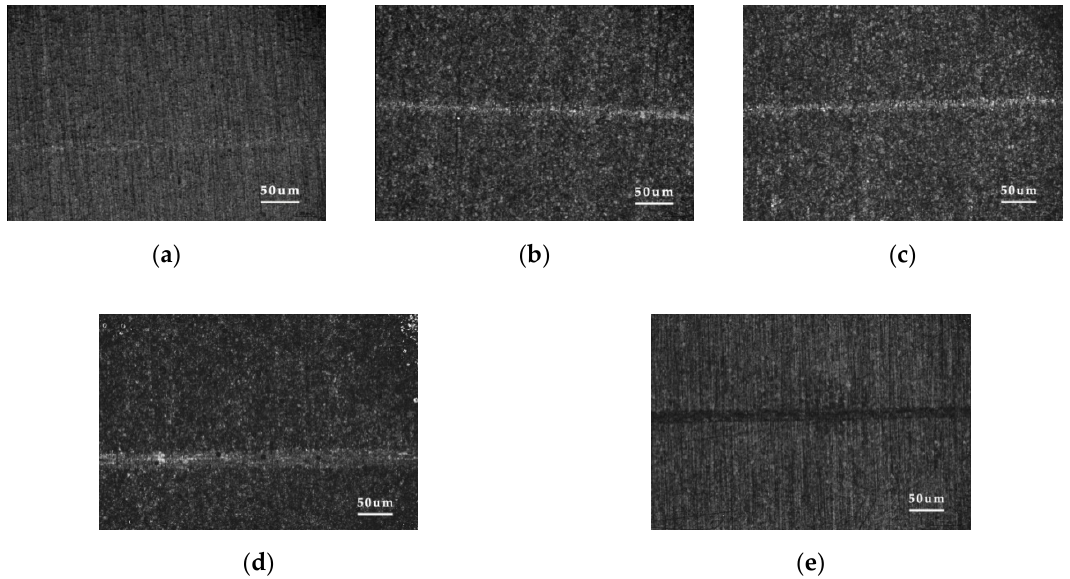
Figure 9. The photographs of scratch marks observed after fretting tests on the surfaces of bare and colored films formed by coloring solutions with different NiSO 4 concentration: ( a ) blank; ( b ) 0.1 g·L − 1 ; ( c ) 0.2 g·L − 1 ; ( d ) 0.3 g·L − 1 ; ( e ) 0.4 g·L − 1 .